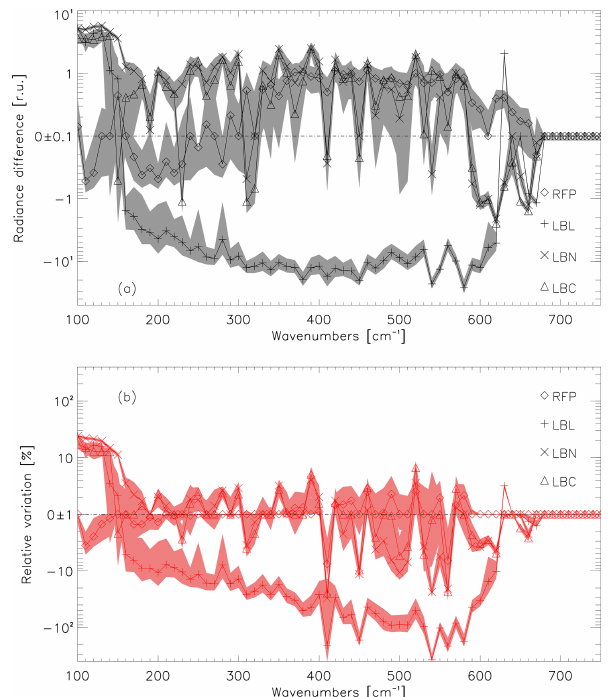
Figure 6. As Fig. 4b for all cases of linear extension, with (a) the ra- diance difference and (b) the relative variation, using (cid:5) for REFIR- PAD (RFP), + for LBLRTM (LBL), x for LBLRTM with noise (LBN) and (cid:49) for coupled LBLRTM